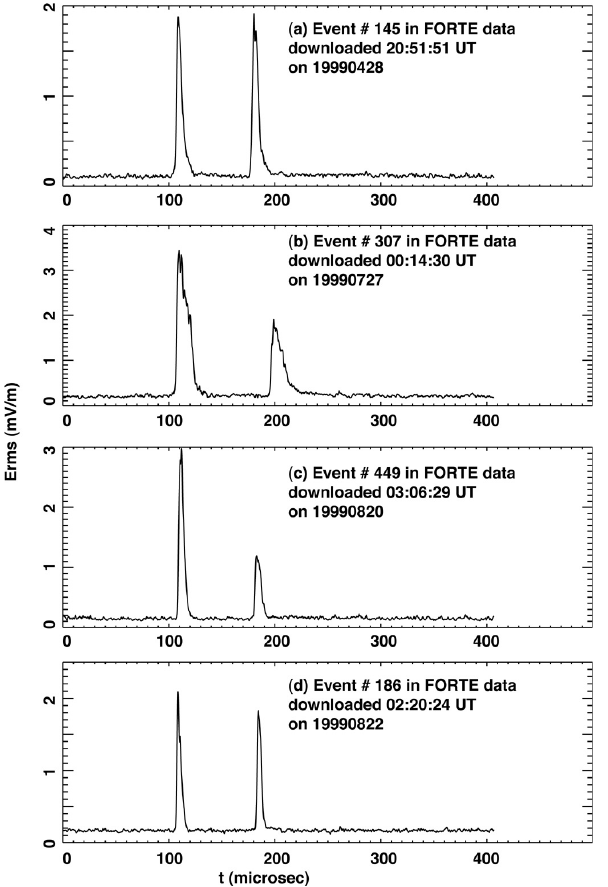
Fig. 12. Similar to Fig. 11, but for the first four strong TIPPs in autonomously triggered TATR records that were coincident with LASA-located NBE strokes.